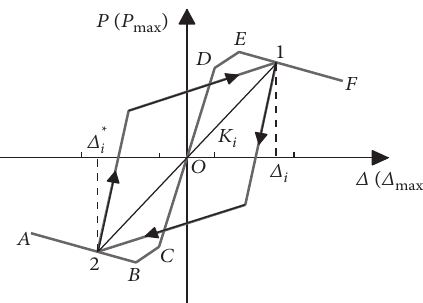
Figure 13: Stiffness degradation